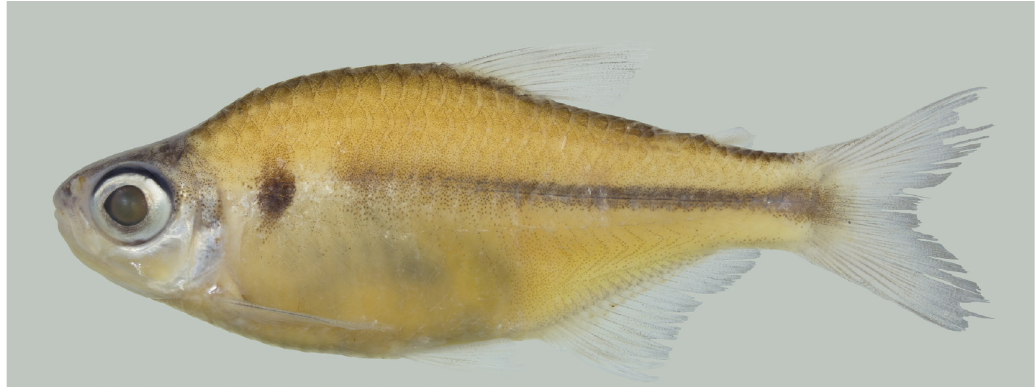
FIGURE 6 | Knodus obolus , holotype, NUP 22667, 46.4 mm SL, ribeirão Dois Irmãos, tributary to the rio do Peixe, tributary to the rio das Almas, tributary to the rio Maranhão, tributary to the rio Tocantins, Municipality of Pirenópolis, Goiás State,